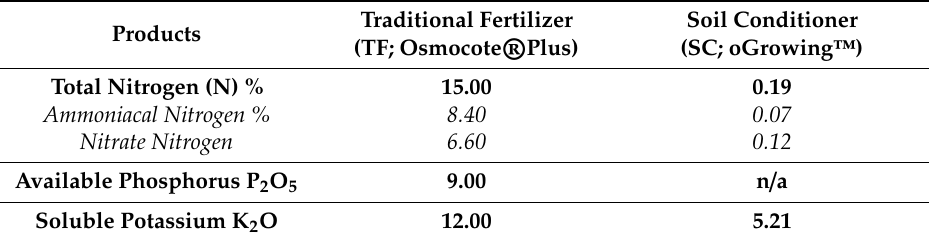
Table 1. Information about labels and mineral content (N-P-K) of the two products used in this study. Products